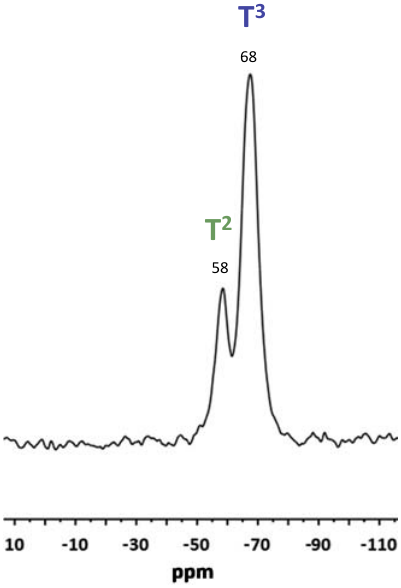
Figure 4. Thermogravimetric-differential (TG-DTA) curves for ( A ) GZA sol and ( B ) GZA xerogel.